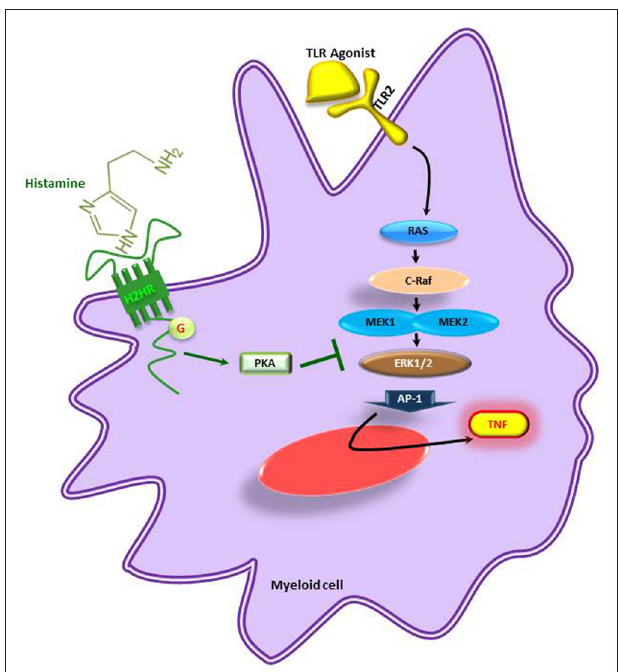
FIGURE 3 | Microbe-derived histamine mediated suppression of pro-inflammatory cytokines. TNF is suppressed by inhibition of the MEK/ERK pathway in myeloid cells. H2HR, histamine receptor 2; PKA, activated protein kinase A; TNF, tumor necrosis factor; TLR, toll-like receptor. Adapted from Thomas et al.